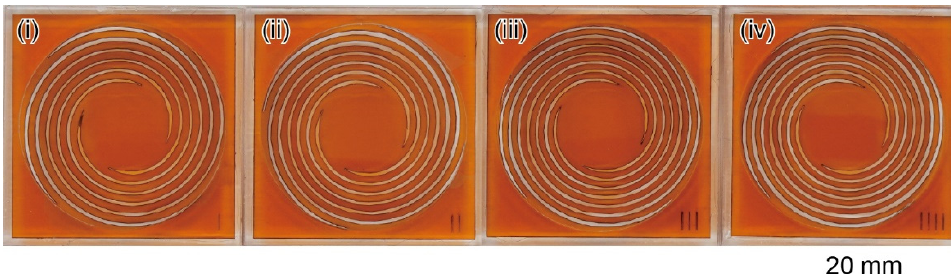
Figure 6. Photograph of the fabricated polyimide force plates according to the parameters and design of (i)–(iv) given in Figures 2 and 3.